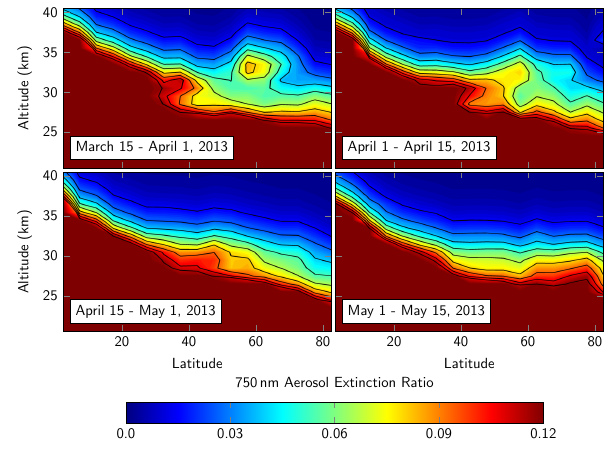
Fig. 4. Zonal average of 750nm extinction ratios (aerosol/background) for the same time periods as Fig.